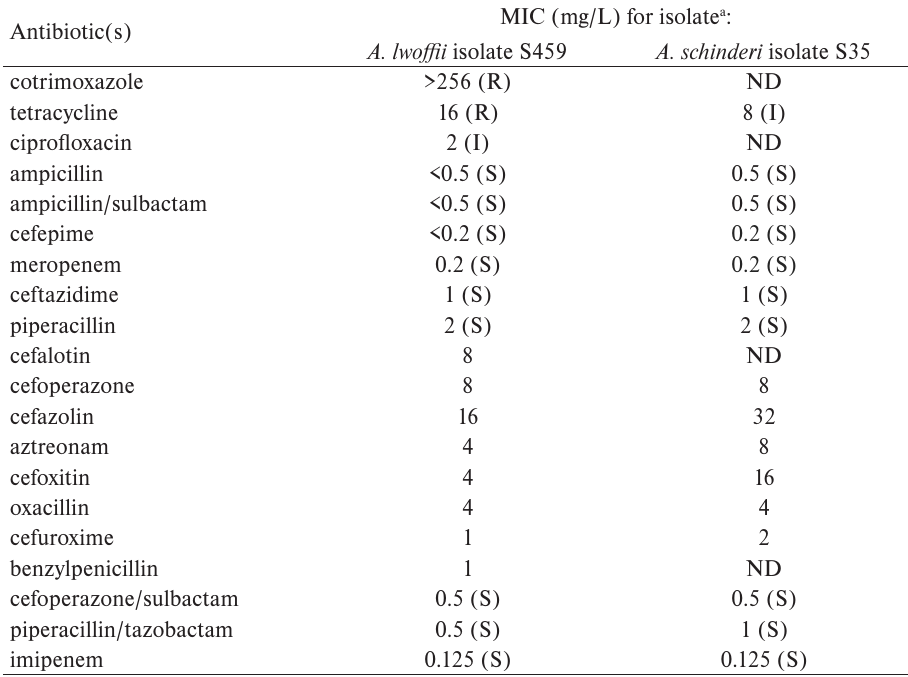
MIC (mg/L) for isolate a